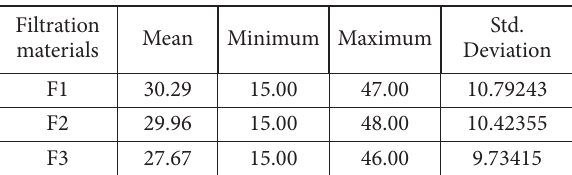
Table 9. Average plant heights by filtration materials (cm) Filtration materials